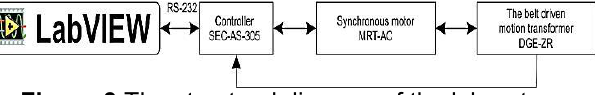
Figure 3. The structural diagram of the laboratory stand "Tracking electric drive FESTO"